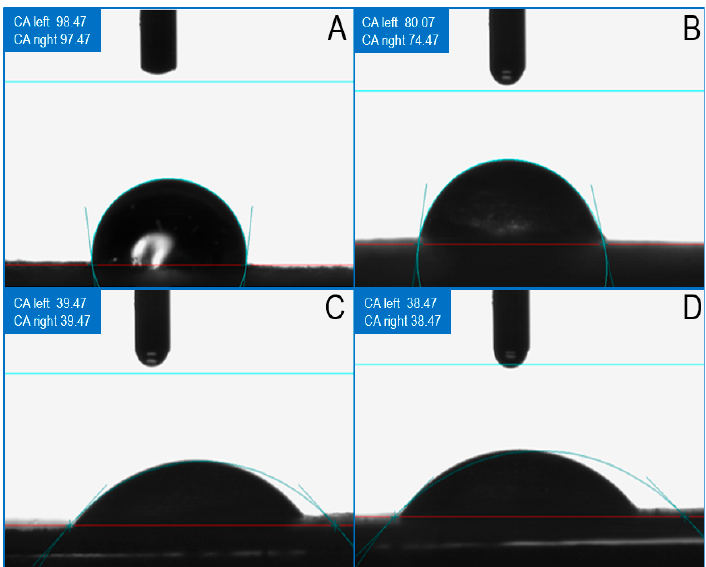
Figure 5. Contact angle with water of different scaffolds. ( A ) 6% PLA film; ( B ) 6% PLA +3% nHAp film; ( C ) 6% PLA +3% nHAp +2% HAAM film; ( D ) 6% PLA +3% nHAp +6% HAAM film.